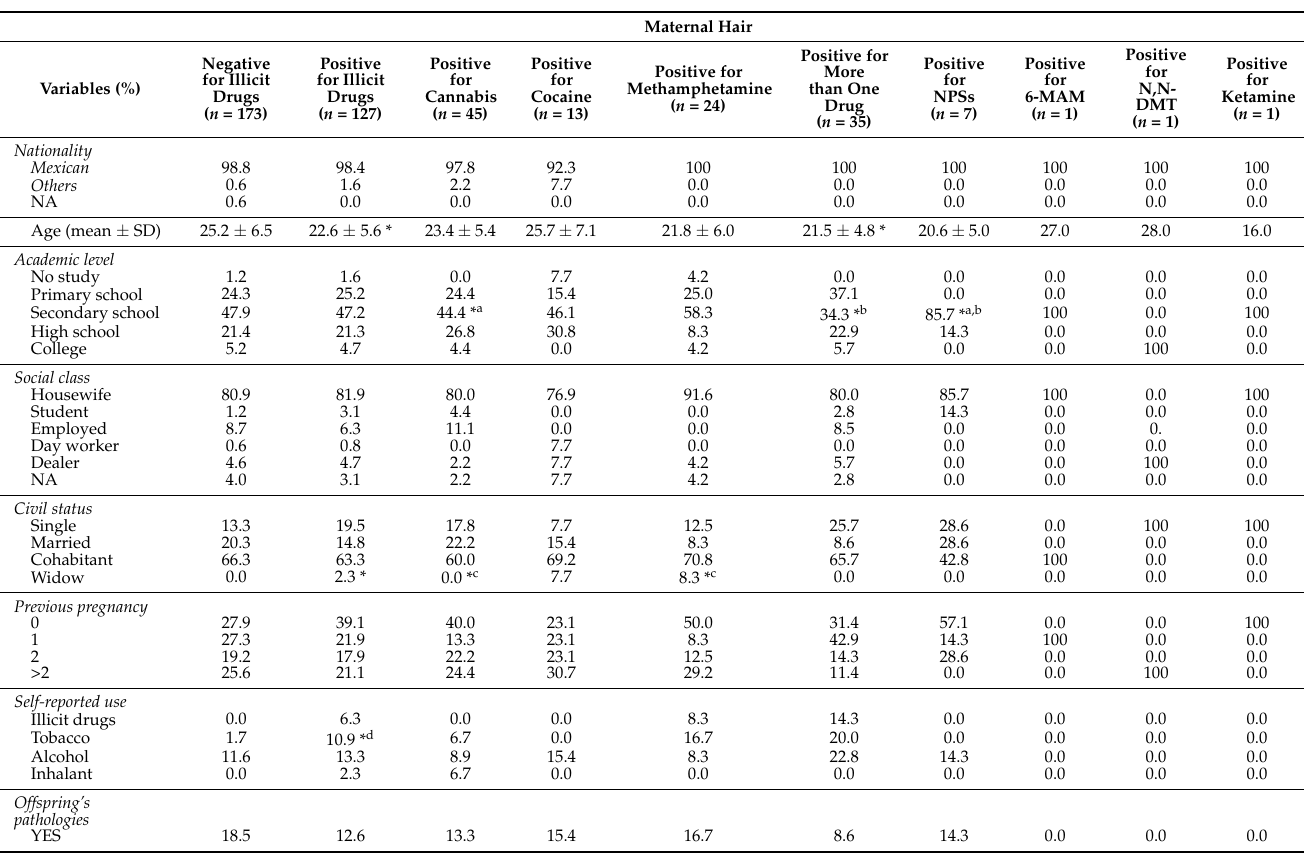
Table 4. Sociodemographic profiles associated with gestational consumption of illicit drugs assessed by hair testing. Maternal